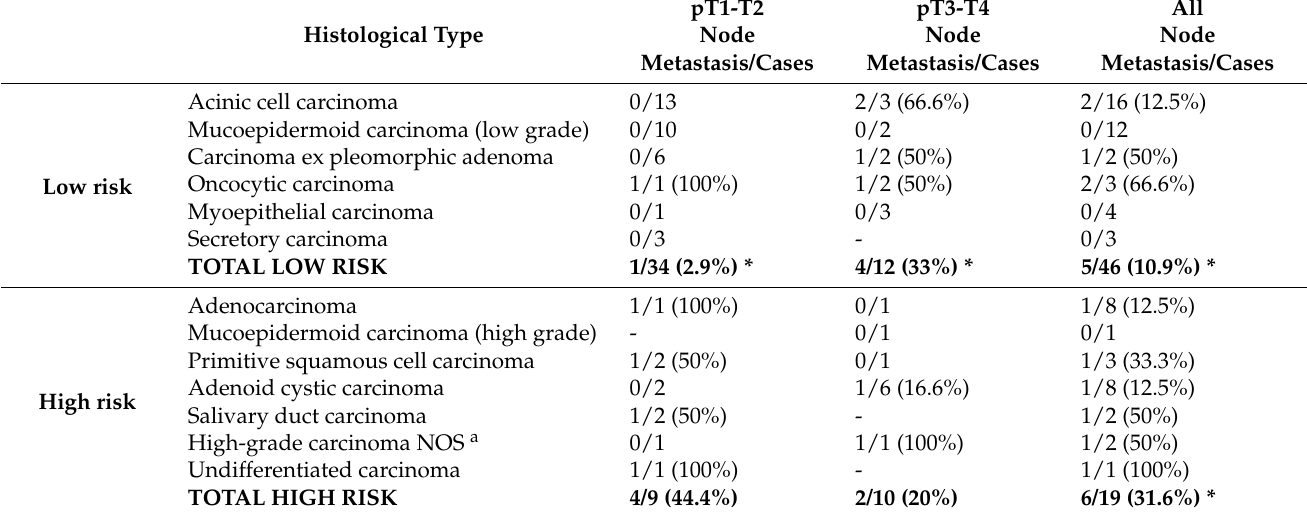
Table 3. Neck metastasis and occult metastasis according to histology.